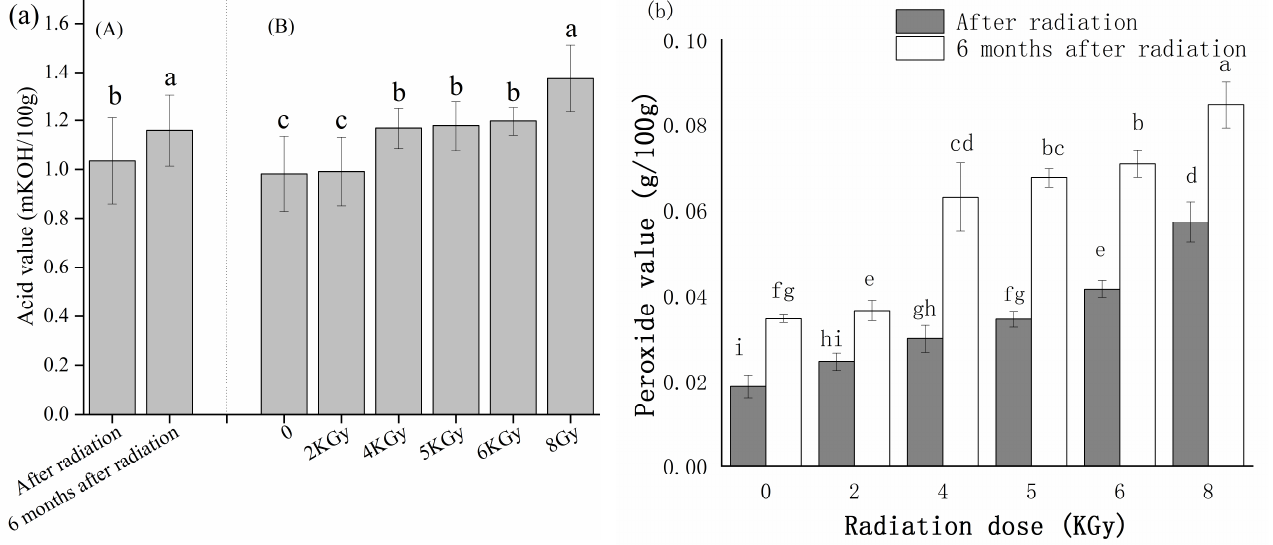
Figure 11. The edible quality of unmildewed sunflower seeds after various doses of γ radiation. Means with different lowercase letters are significantly different ( p < 0.05). Bars represent the standard deviations. ( a ) Acid values [(A) Storage time; (B) Radiation dose.]; ( b ) peroxide values.